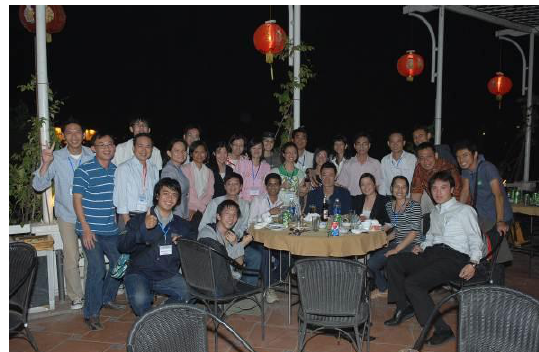
Figure 3. Group photo of ISPRS-SC Summer School 2010 in